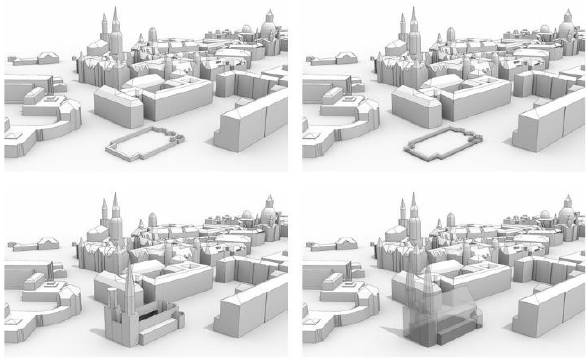
Figure 2. Digital 3D reconstruction of the ruin of the Sophienkirche in Dresden: spatialized floor plan opaque (above left) and transparent (above right), destroyed building (bottom left), complete church transparent (bottom